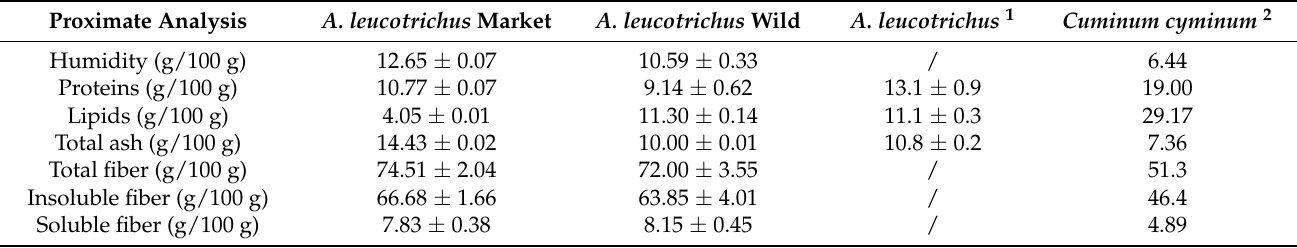
Table 1. Proximate analysis of A. leucotrichus samples compared to literature data for A. leucotrichus and C. cyminum .